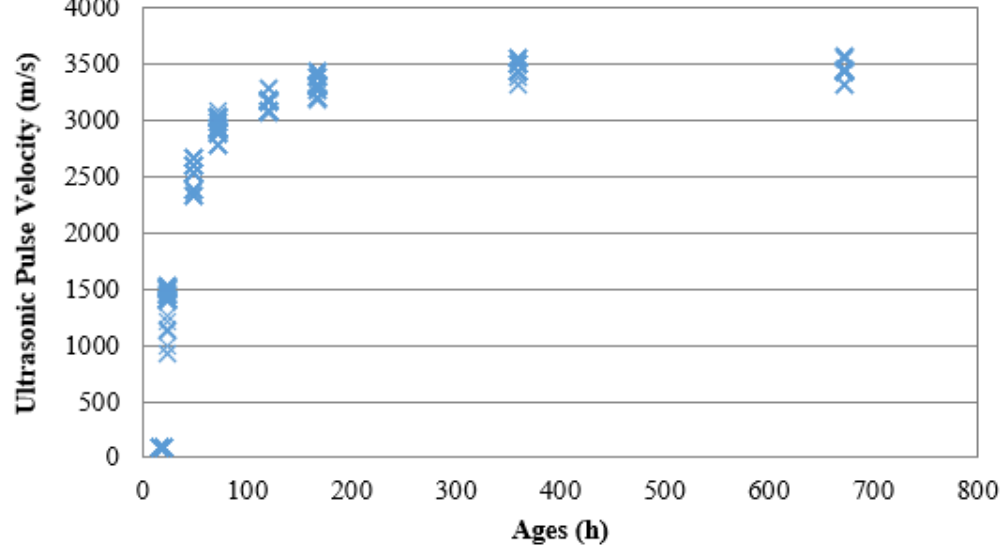
Figure 10. Ultrasonic pulse velocity with age (40 MPa).